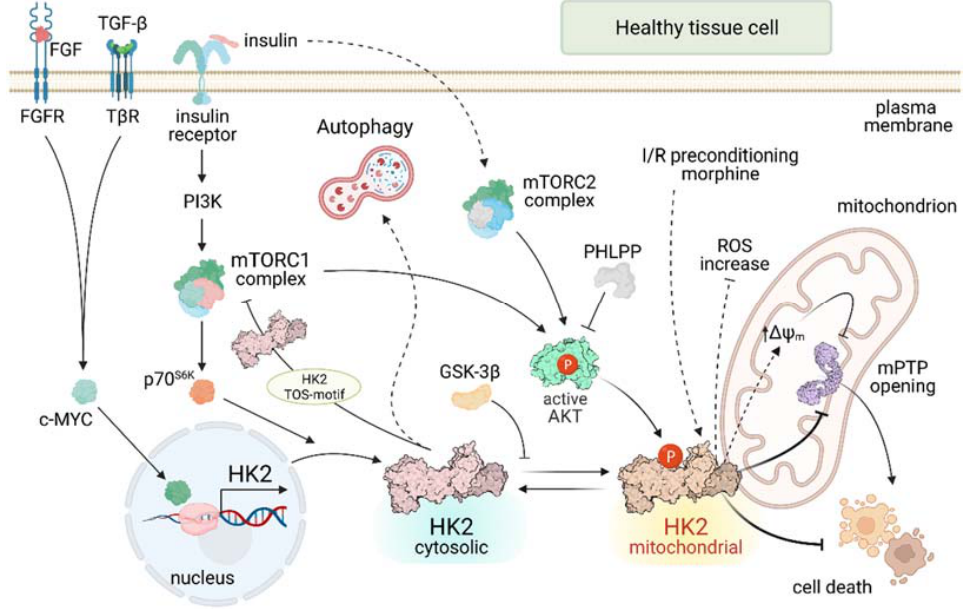
Figure 1. HK2 regulatory pathways in healthy cells. Continuous lines indicate direct effects; dashed lines indicate indirect effects. FGF: Fibroblast Growth Factor; FGFR: Fibroblast Growth Factor Receptor; TGF- β : Transforming Growth Factor β ; T β R: Transforming Growth Factor β Receptor; PI3K: PhosphoInositide-3-Kinase; mTORC: mammalian Target of Rapamycin Complex; p70S6K: p70-S6 Kinase 1; GSK-3 β Glycogen Synthase Kinase 3 β ; PHLPP: PH domain and Leucine rich repeat Protein Phosphatase; ΔΨ m : mitochondrial membrane potential; mPTP: mitochondrial Permeability Transition